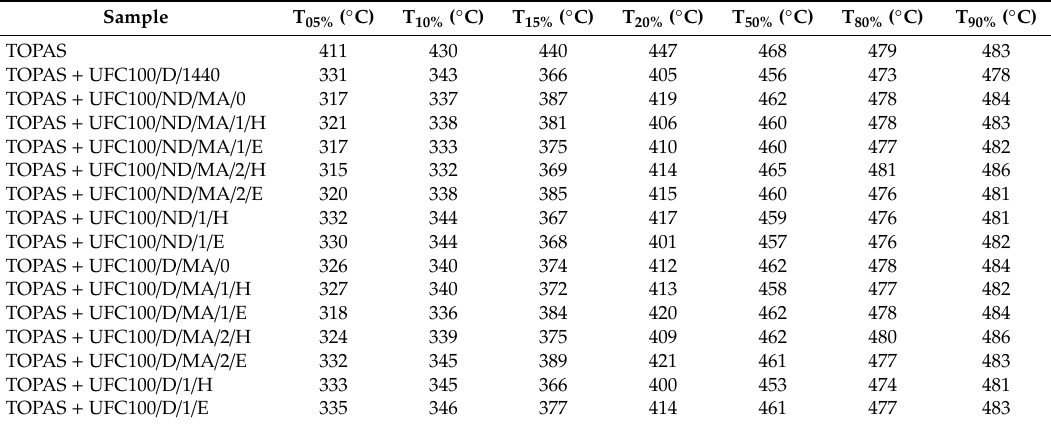
Table 4. Tabularized values of apparent activation energy assigned to the decomposition steps calculated with the use of Broido’s method [39]; E (cid:2885) —apparent activation energy of cellulose (cid:3117) degradation, E (cid:2885) —apparent activation energy of polymer matrix decomposition. (cid:3118)